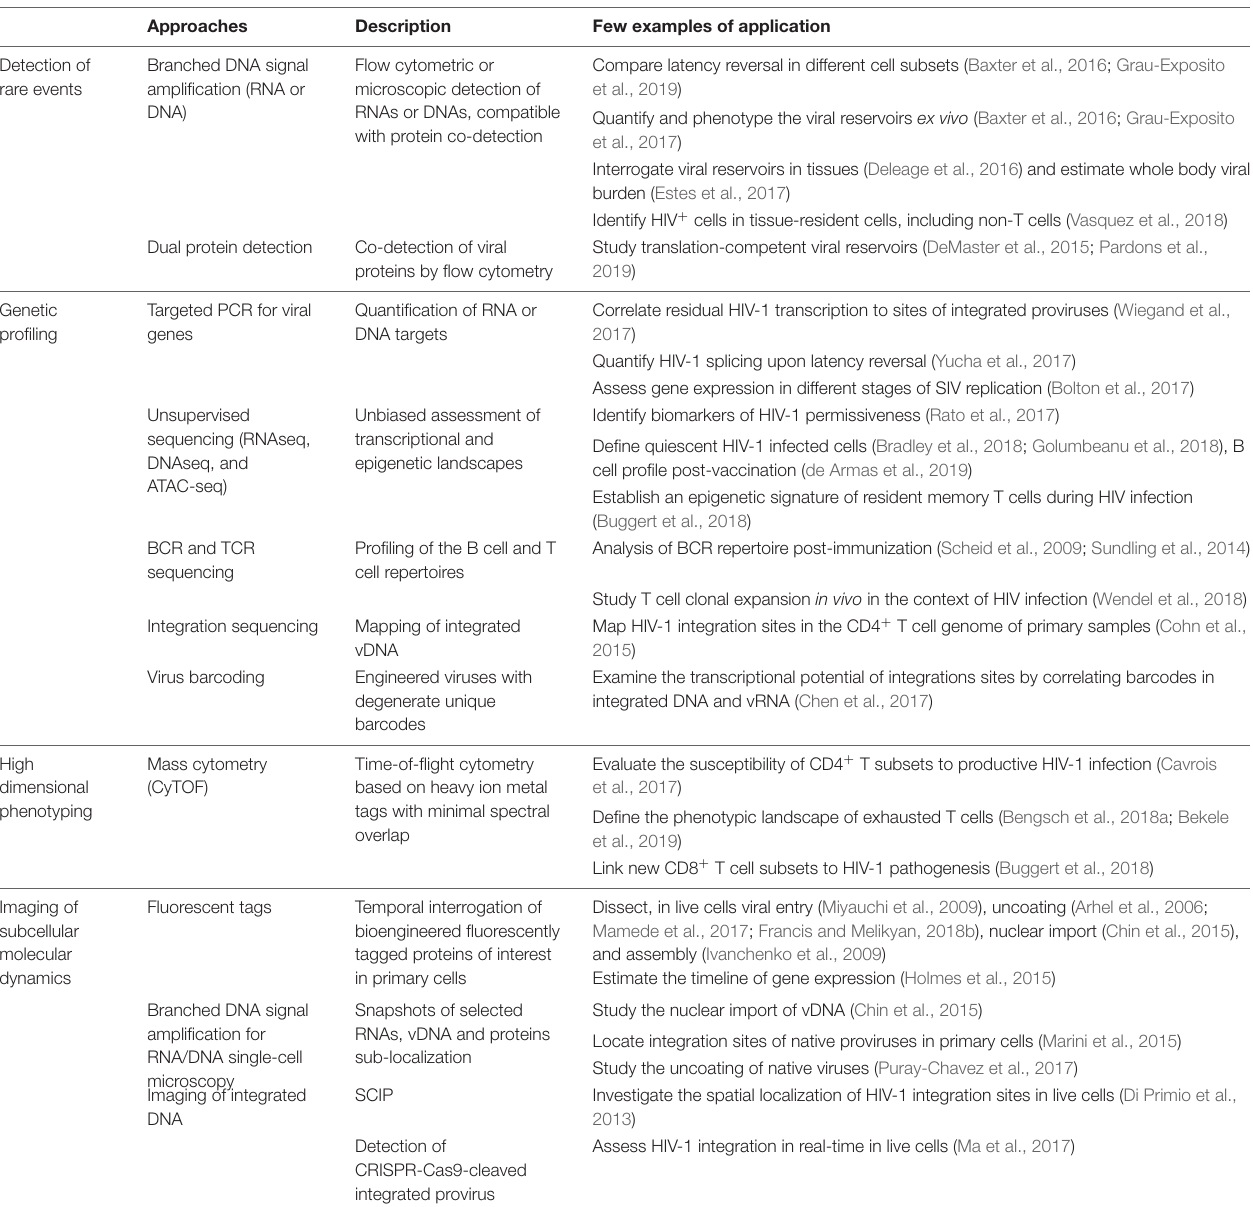
TABLE 1 | Some examples of studies providing single-cell insight into HIV-1 biology or pathogenesis.